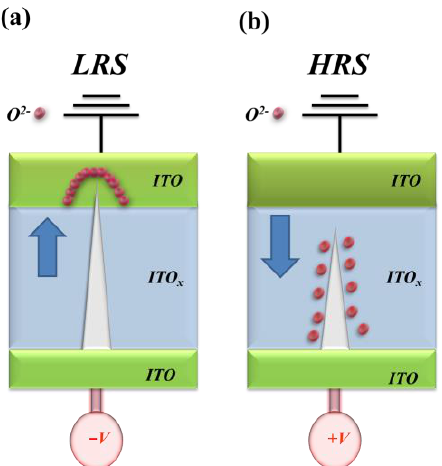
Figure 13. Optical images of the transparent ITO/ITO X /ITO RRAM device.